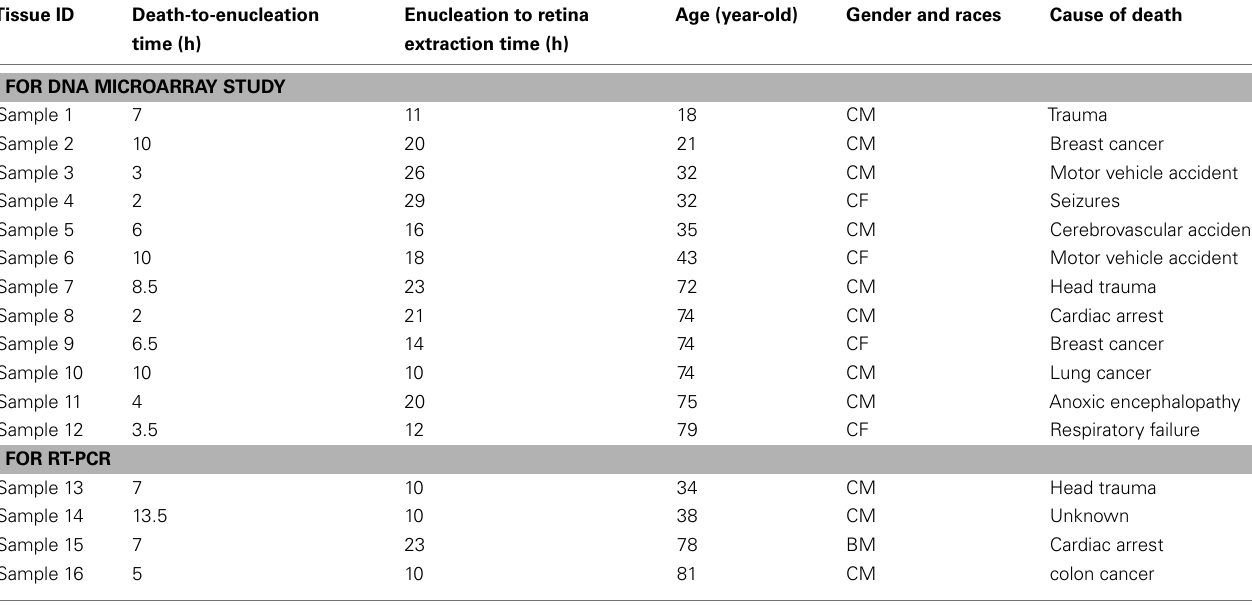
Table 1 | Human retina donor information.